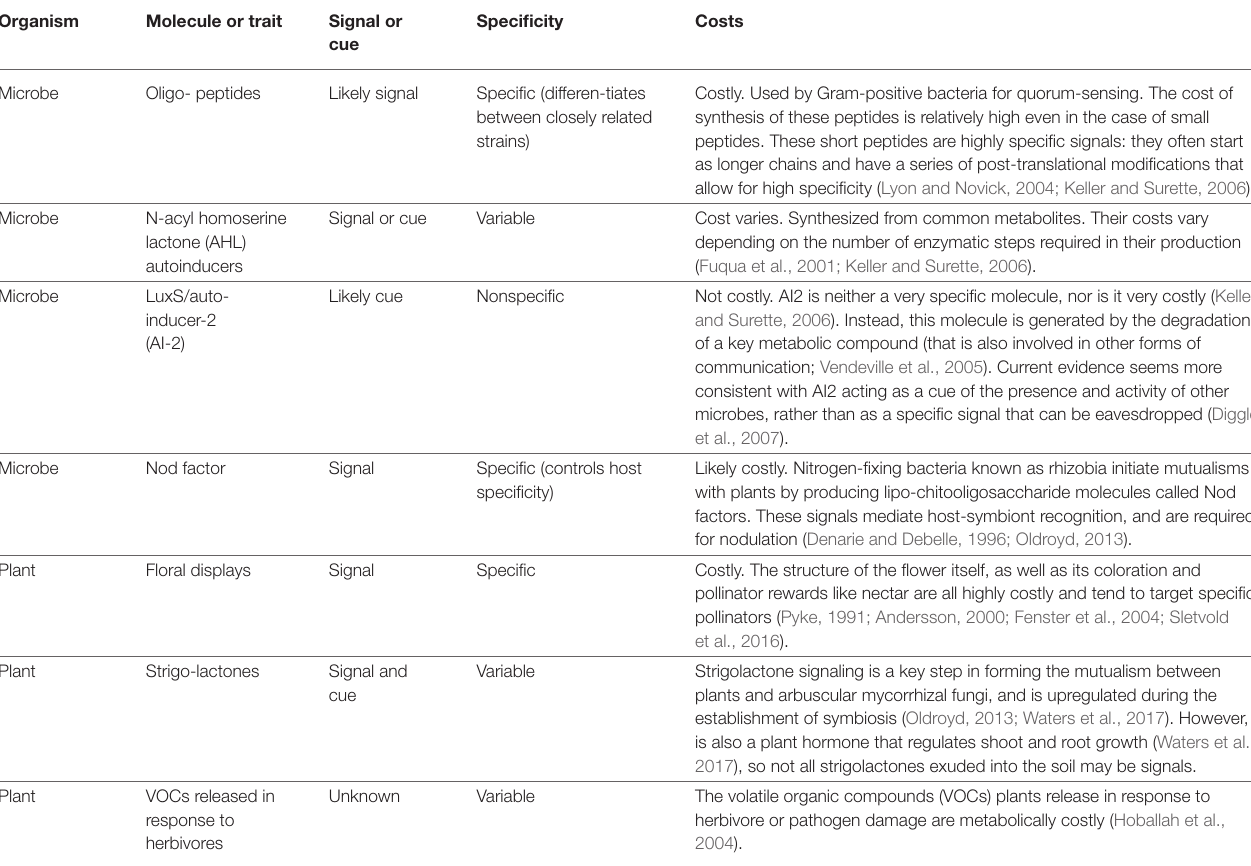
TABLE 1 | Examples of signals and cues in microbes and plants.